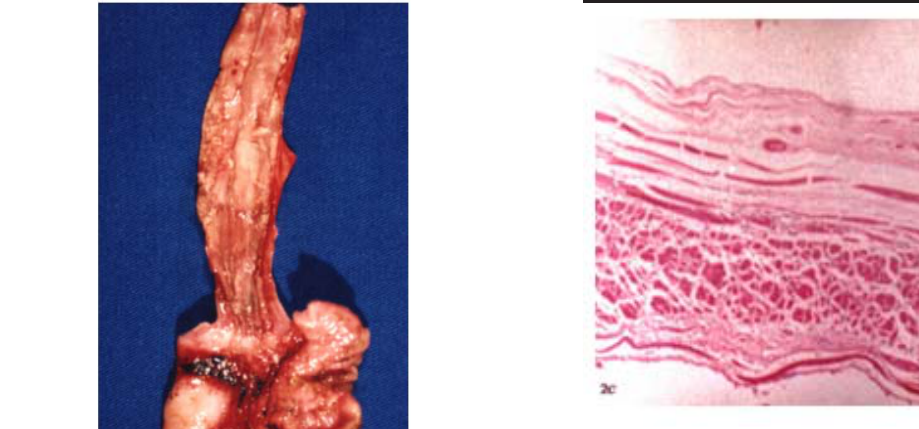
FIGURE 4 -Adventitial edema, hemorrhage and inflammatory process provoked by esophageal infusion of NaOH solution